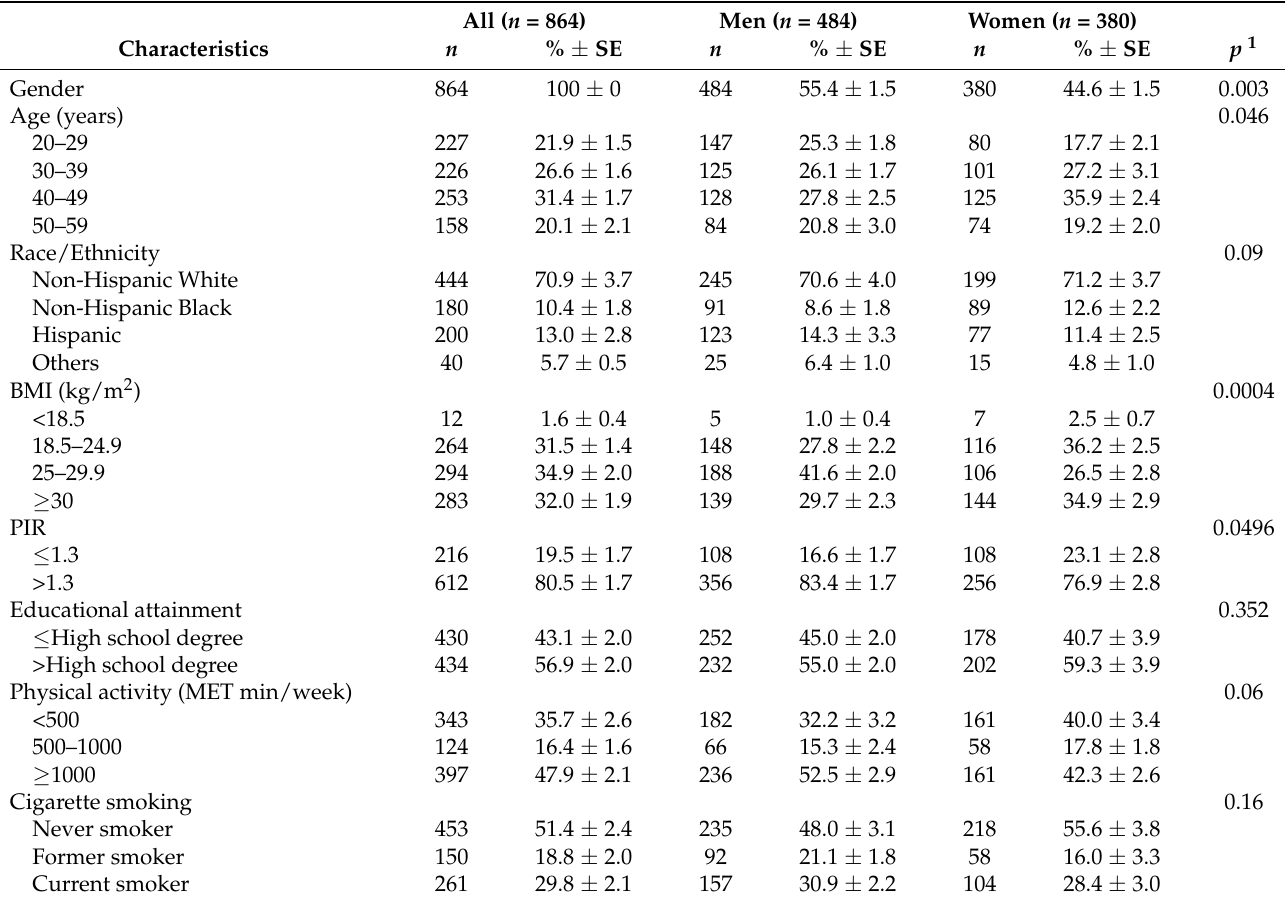
Table 1. Demographic, socioeconomic, and other characteristics of participants by gender among US adults aged 20–59 y, NHANES